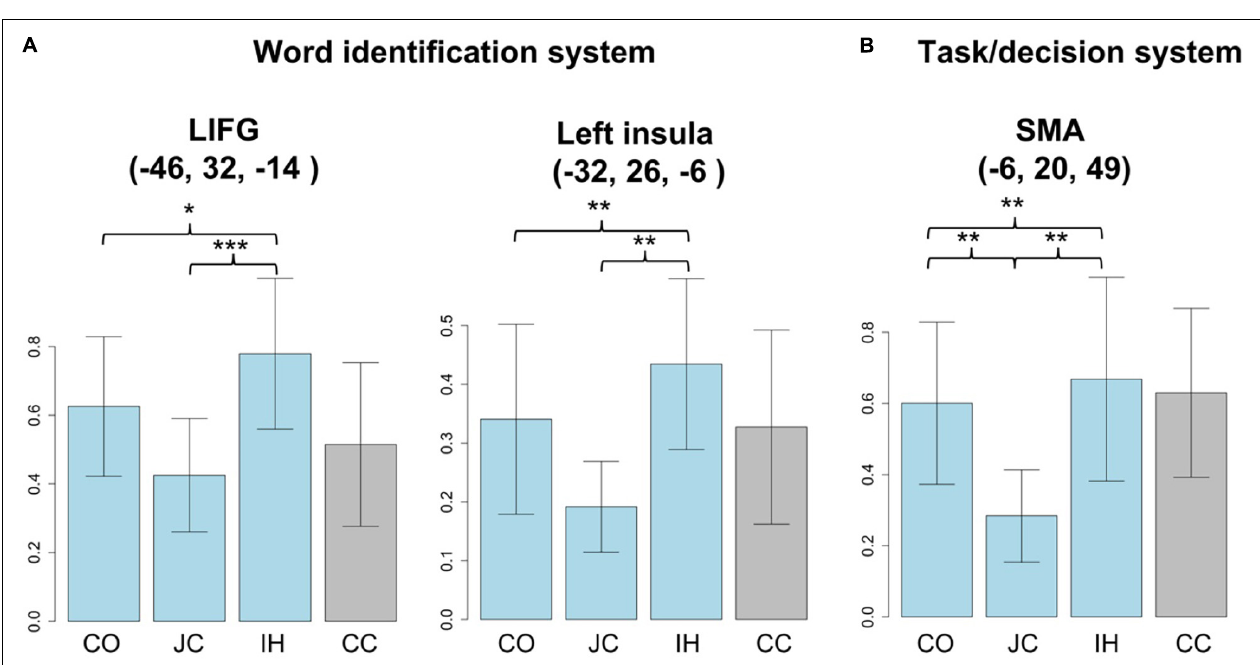
FIGURE 3 | Brain areas observed by comparisons between types of words. In (A) , the contrast of [interlingual homograph (IH) > Japanese control word (JC)] revealed significant activation of the left orbital part of the IFG and the supplementary motor area. In (B) , the contrast of [cognate (CO) > Japanese control word (JC)] revealed activation in the supplementary motor area. The threshold was set at p < 0.05 after cluster-level correction (initial voxel-level height threshold, p < 0.001).